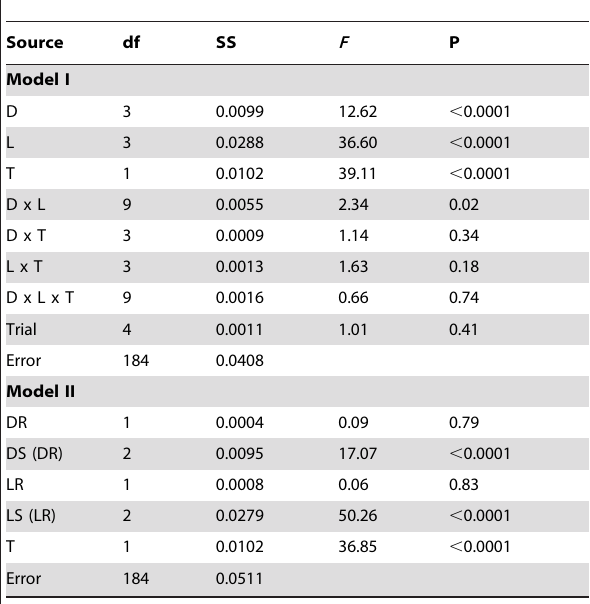
Table 1. Results of general linear models testing the effects of detritivore and plant litter assemblages and water temperature on detritivore-mediated decomposition rates (measured as the proportion of leaf weight loss per capita).